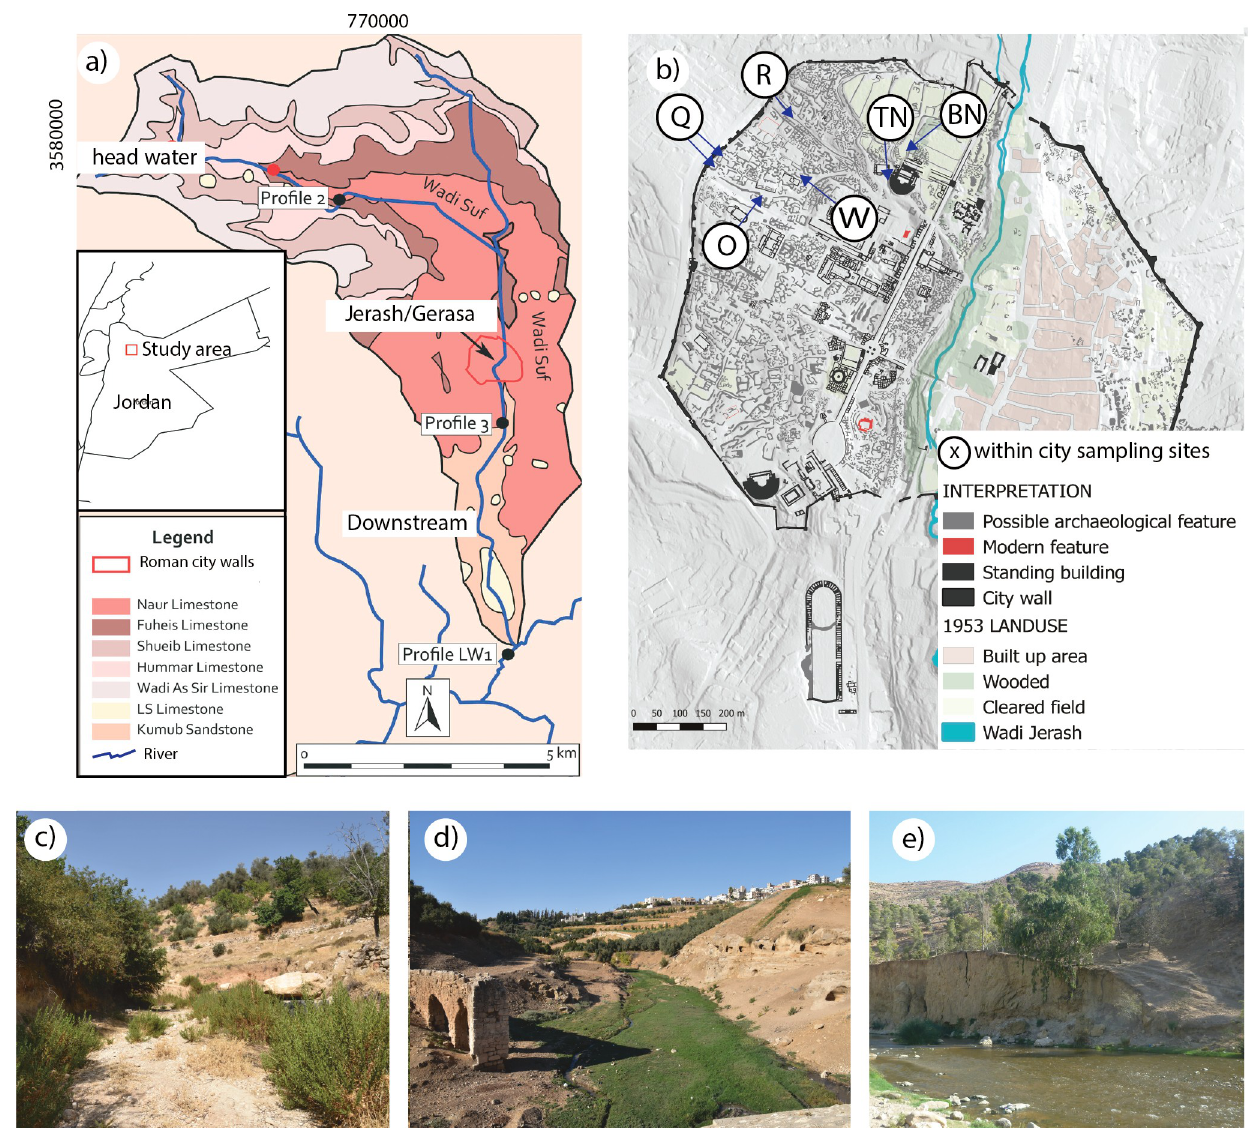
Fig 1. Map of the Wadi Suf watershed with the locations of profiles (A), map of the ancient city showing within city sampling locations (x), ancient sewage water sediments, Red Mediterranean soils, and urban sediments (B), and images of sampling locations in the wadi headwaters (C), the middle section (D) and downstream (E). Background maps from [11,